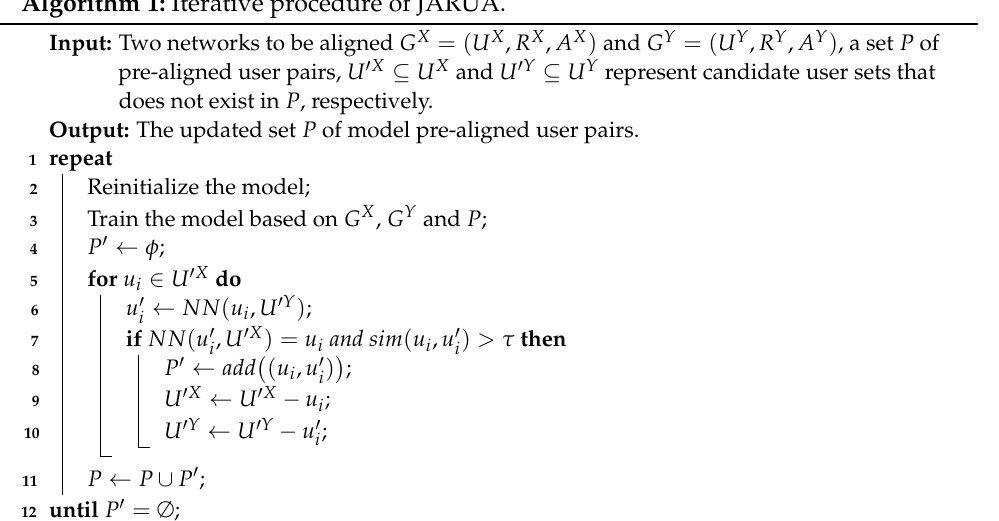
Algorithm 1: Iterative procedure of JARUA.